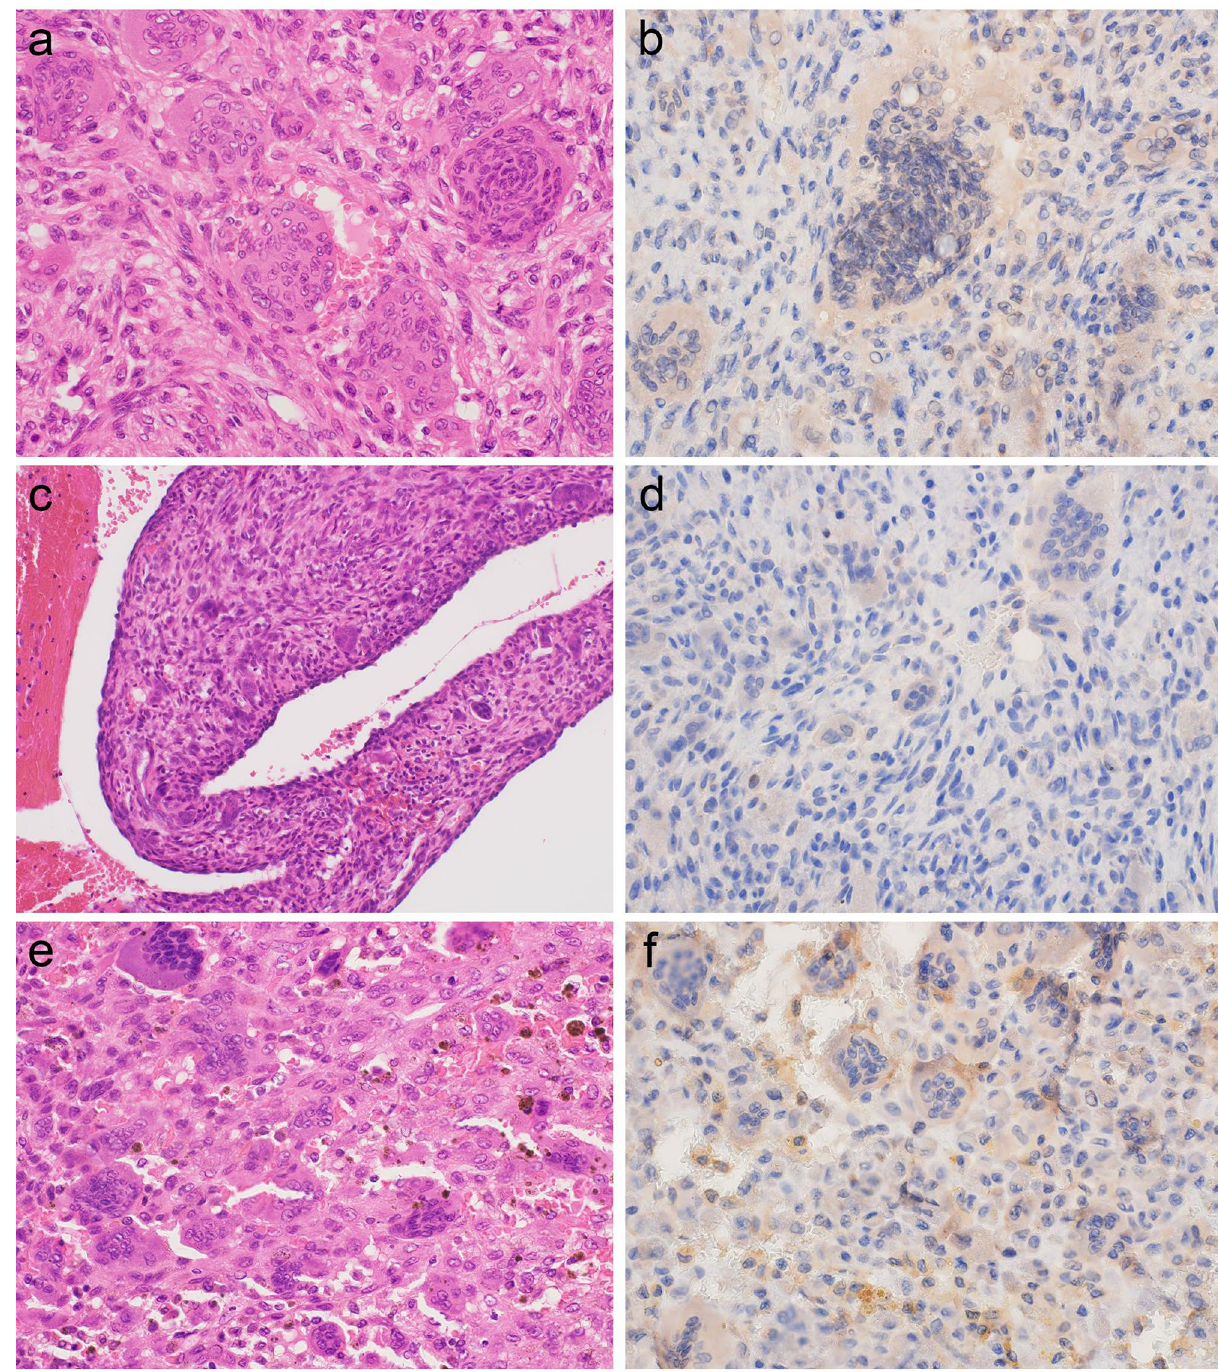
Fig. 3 Histology and CSF1 immunohistochemistry of giant cell tumor of bone, aneurysmal bone cyst, and giant cell reparative granuloma a. Giant cell tumor of bone consisted of solid proliferation of histiocyte-like mononuclear cells with many osteoclast-like giant cells b. The mononuclear tumor cells were negative for CSF1. c. Aneurysmal bone cyst exhibited a blood-filled cystic space separated by fibrous septa. The fibrous septa consisted of mononuclear and fibroblastic spindle cells with osteoclast-like giant cells d. The mononuclear cells were negative for CSF1. e. Giant cell reparative granuloma was composed of diffuse proliferation of mononuclear to spindle cells without atypia accompanying osteoclast-like giant cells f. The mononuclear cells were negative for